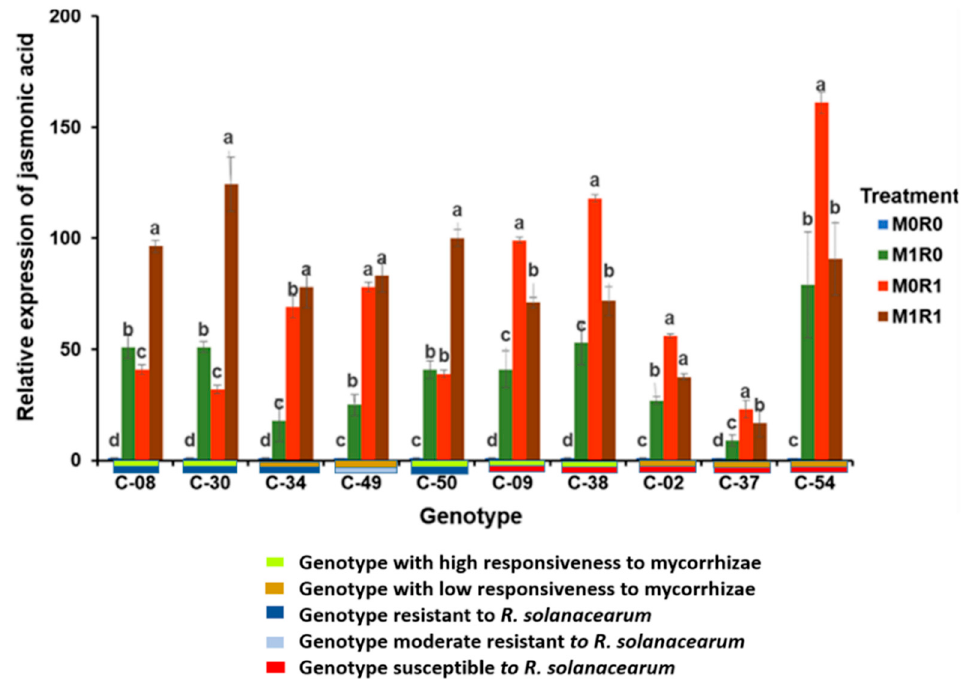
Figure 2. Relative gene expression of jasmonic acid (JA) in the tropical chili pepper genotypes. Note: Plants without mycorrhizae (M0); plants inoculated with mycorrhizae (M1); plants without R. solanacearum (R0); plants inoculated with R. solanacearum (R1). Bars represent the mean ± standard deviation. The same lowercase letters indicate no significant difference in the mean values between treatments in each genotype, according to the Scott-Knott test, at a significance level of 0.95. Inoculating mycorrhizae but not R. solanacearum (M1R0) showed that mycorrhizae caused the relative gene expression of JA to increase in the chili pepper genotypes.